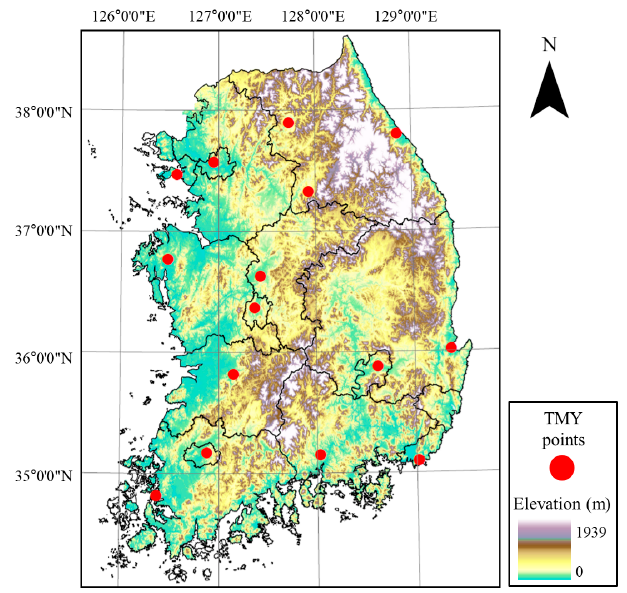
Figure 2. Digital Elevation Model (DEM) and Typical Meteorological Year (TMY) data observation points in Korea.